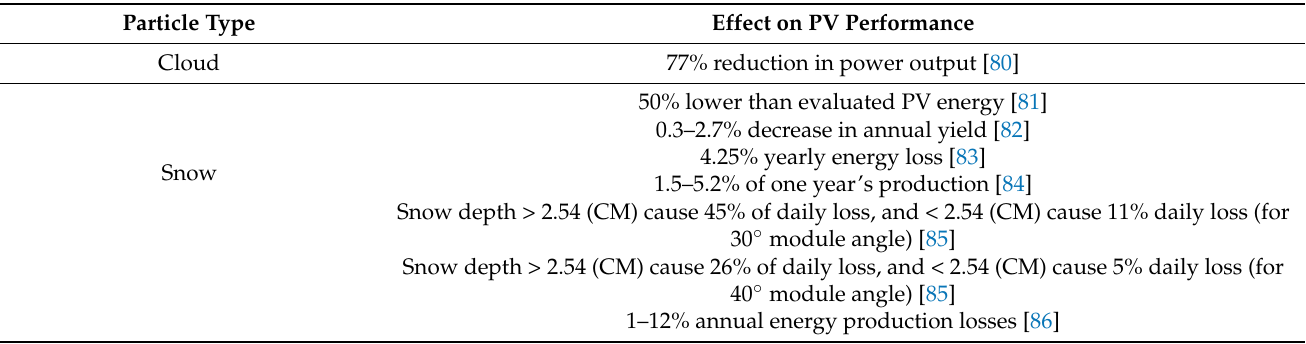
Table 3. Power reductions due to cloud and snow.